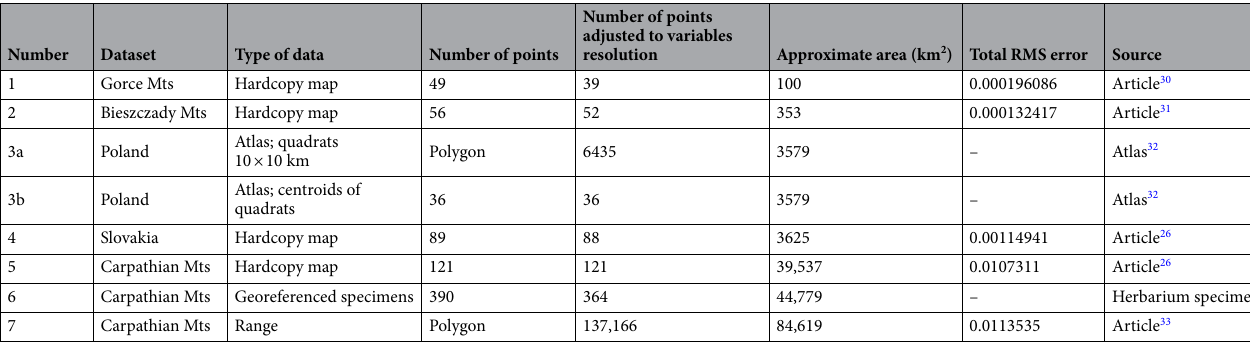
taken from 26 . A distributional area in the Carpathians (7) was taken from 33 ; this map shows a range based on expert opinion. In this case, the range was drawn so as to enclose areas of the Carpathian Mountains within the minimum and maximum elevation range of recorded species occurrence. The polygons were converted to points by aligning them to the pixel centroids of a raster with resolution of 30 arc seconds, so that each cell covered by a polygon was treated as a point occurrence. Hardcopy maps were scanned, and georeferencing was done by selecting characteristic tie points from the maps and aligning them to vector maps of a given area. Depending on the map, tie points were placed at cross- roads, rivers, political borders, or other characteristic places. Tie points were added until visually appealing results were achieved (i.e., all river and border lines matched). Afterward, species presence records were digitized and saved as a point dataset. In some cases, the black circles marking presence were large, ellipsoidal, blurred, or strongly overlapping, making it difficult to pinpoint the exact center of the mark. All datasets yielded the minimum number of 13 points that has been recommended to achieve reliable modeling results 35 , but the more local datasets should be regarded as biased or clumped, since the points were usually close to each other. The occurrence points from all datasets were thinned to only a single presence per pixel and aligned to pixel centroids of raster files of environmental predictor variables (Appendix 1).